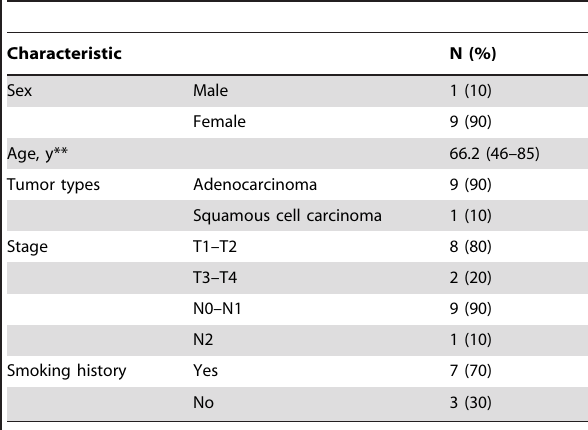
Table 1. Clinicopathologic characteristics of 10 lung cancer patients used for miR31 analysis *